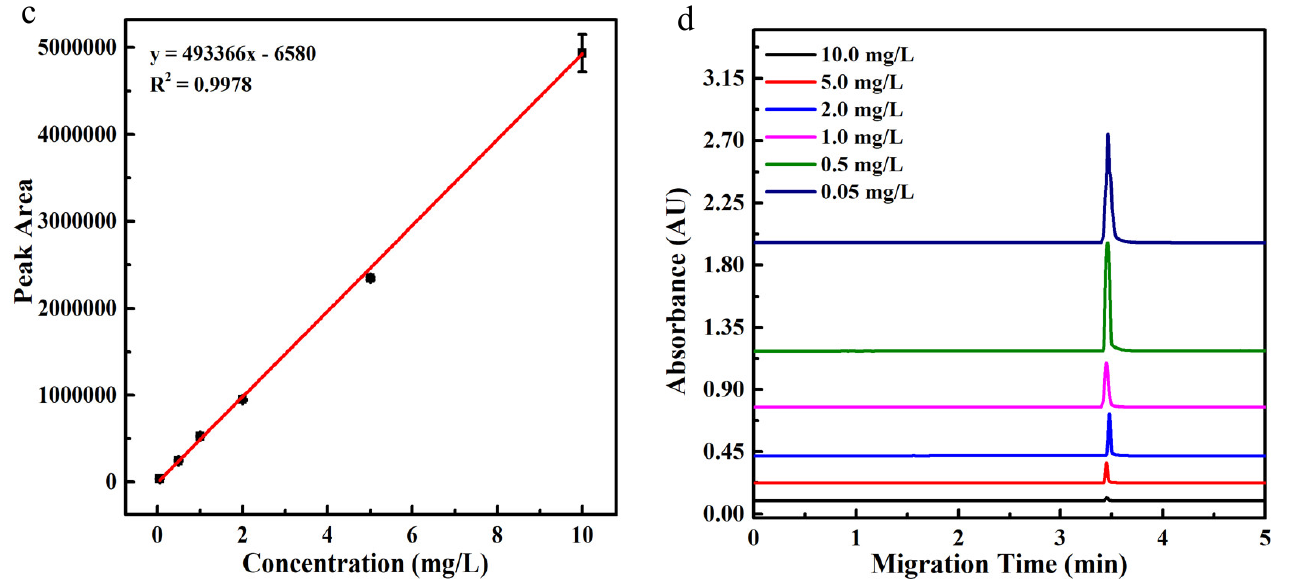
Figure 3. ( a ) Linear relationship between CE absorbance and the concentration of histamine ranging from 0.1μg/L to 100.0 μg/L after MISPE treatment. ( b ) Electropherograms at different histamine concentrations (0.1–100.0 μg/L) after MISPE treatment. ( c ) Linear relationship between the CE absorbance and the concentration of the histamine in the range 0.05–10.0 mg/L. ( d ) Electropherograms at different histamine concentrations in the range 0.05–10.0 mg/L.